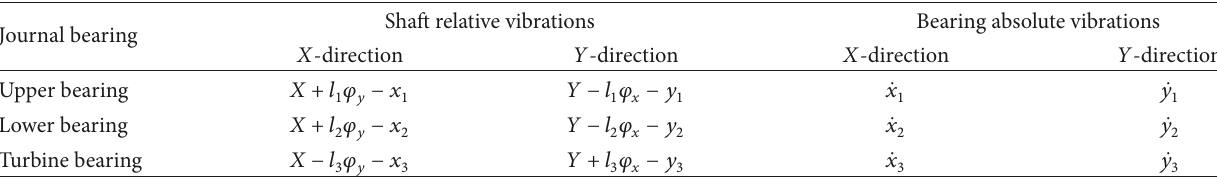
Table 3: Shaft relative vibrations measured by proximity transducers (in displacement) and bearing absolute vibrations measured by piezoelectric accelerometers and integrated by charge amplifiers (in velocity).